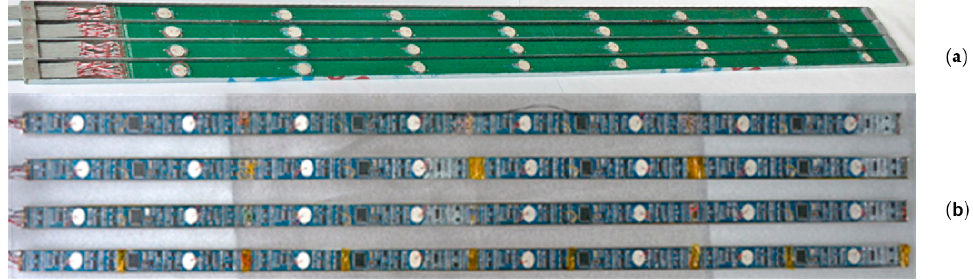
Figure 12. Traditional reception circuits ( a ), and intellectualized active reception circuits ( b ).